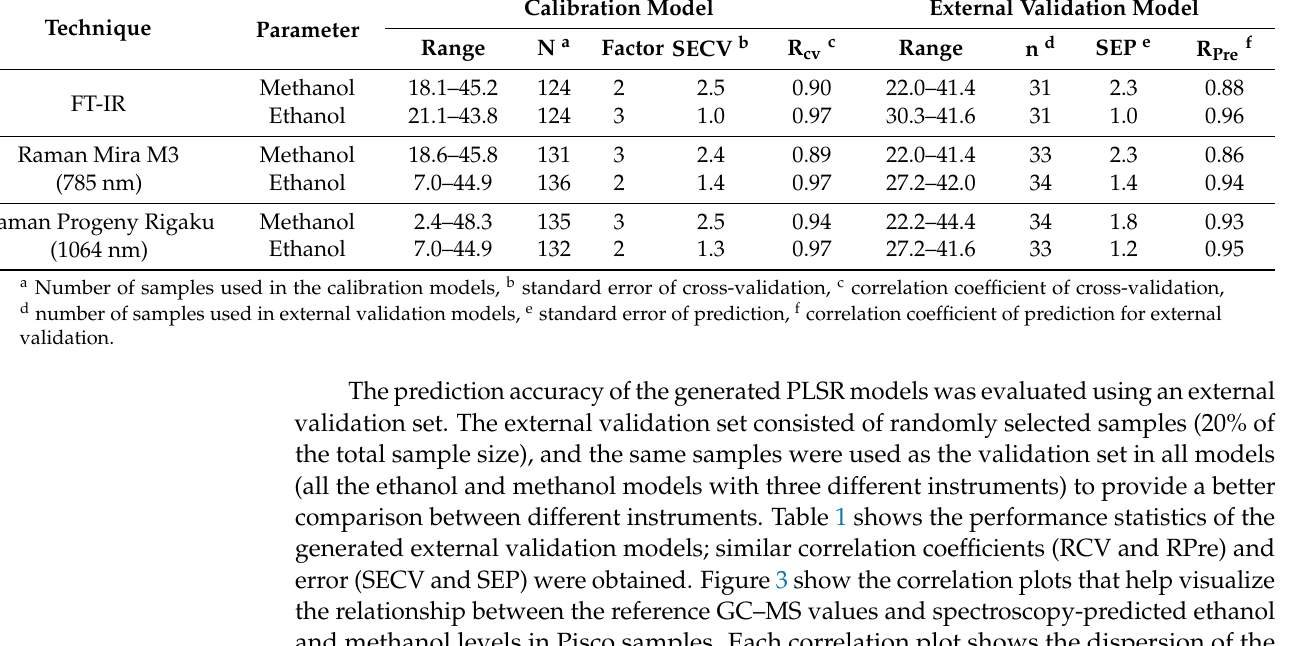
Table 1. Performance of calibration and validation models developed by using handheld and portable vibrational spec- troscopy devices for the determination of ethanol and methanol levels in Peruvian Pisco samples.